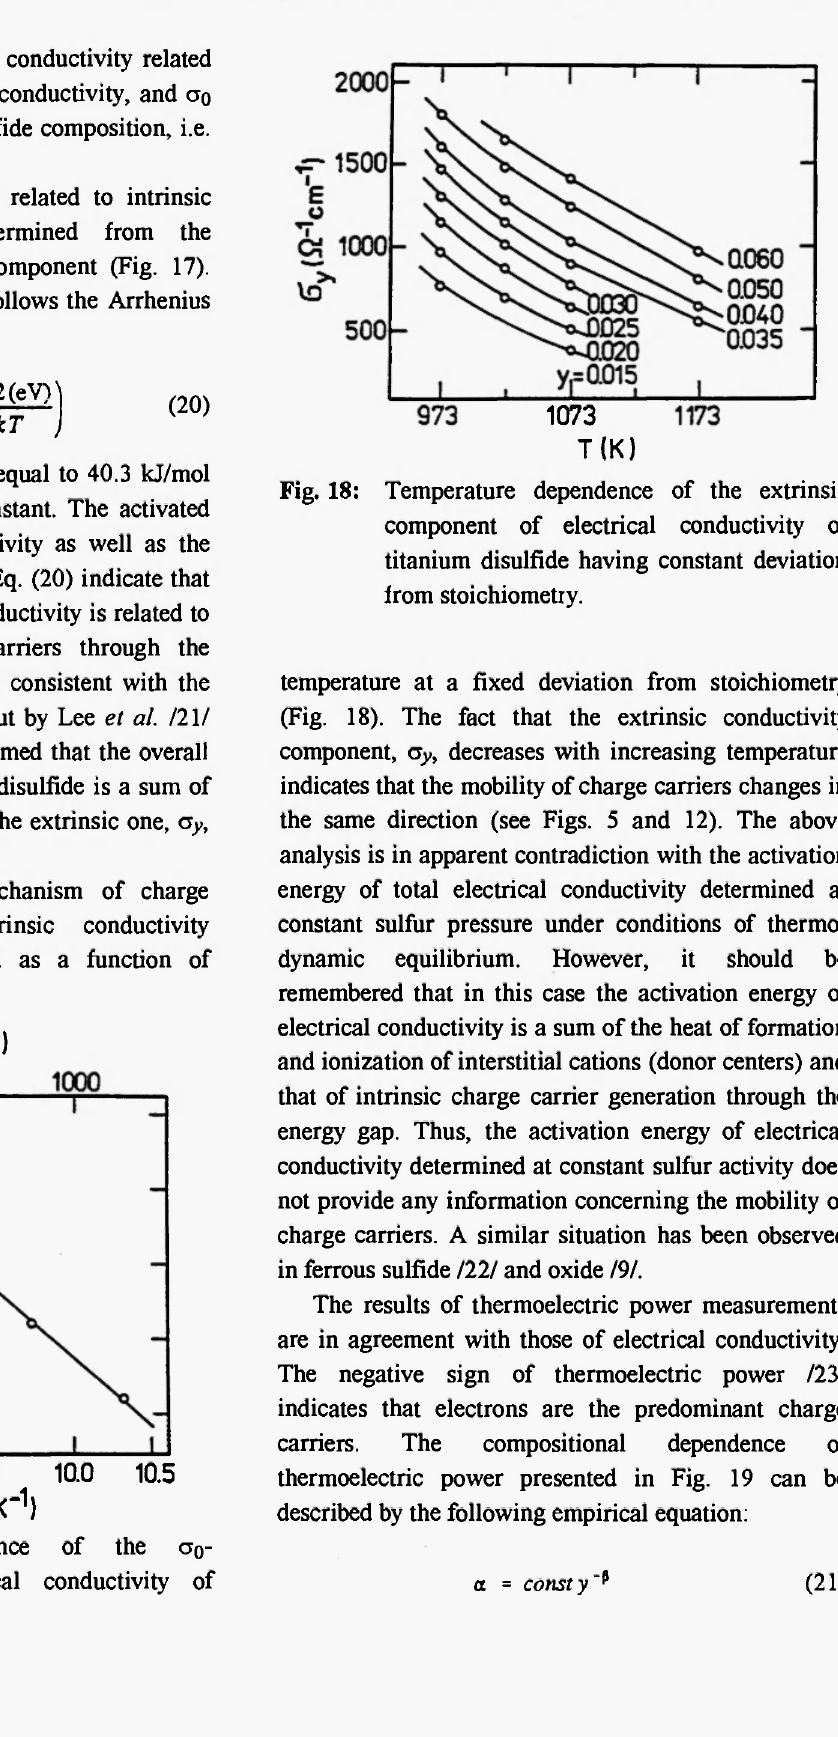
Fig. 17: Temperature dependence of the σο- component of electrical conductivity of titanium disulfide.